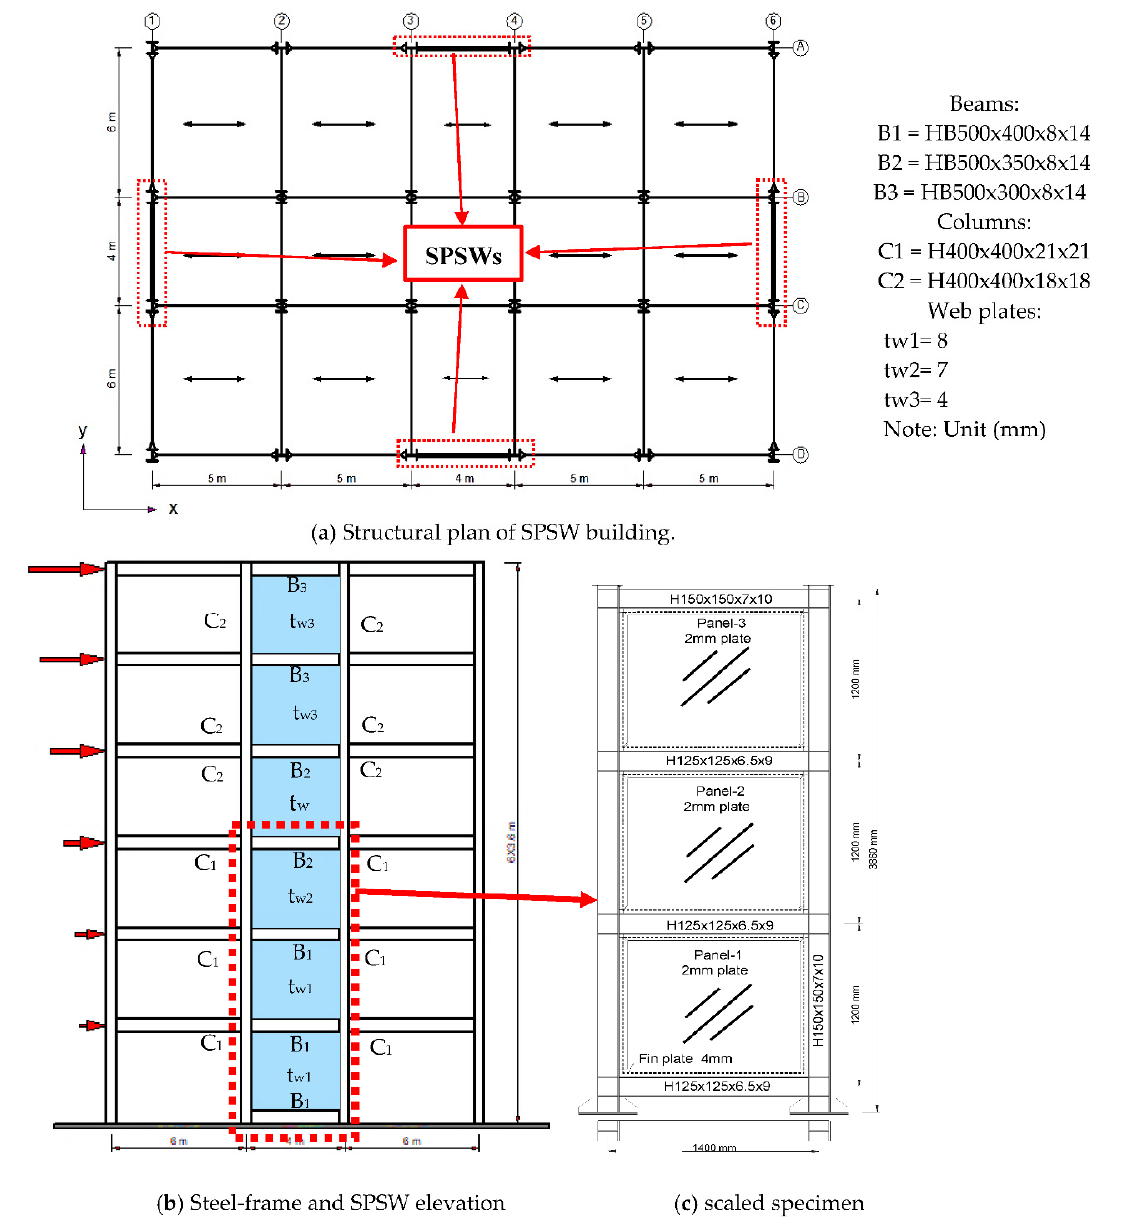
Figure 1. Details of the SPSW building and test specimen.